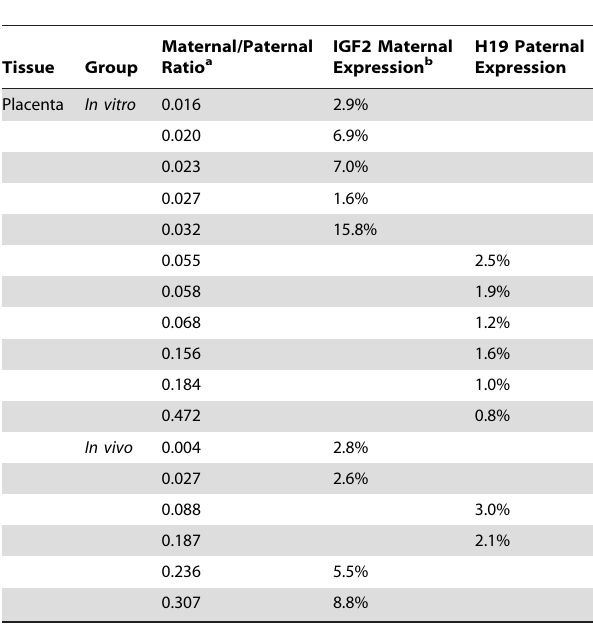
Table 3. Allelic-specific expression of IGF2 and H19 in human placenta.